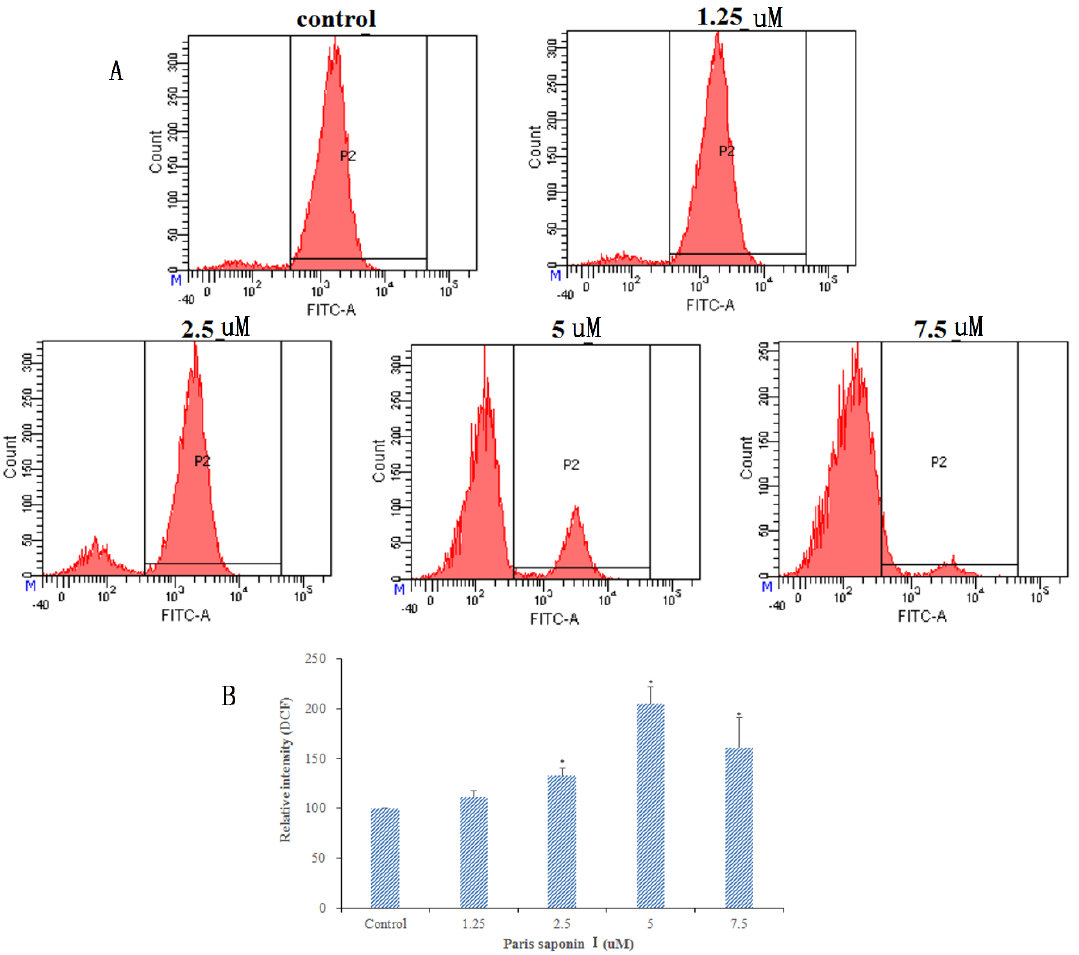
Figure 6. Effect of PSI on reactive oxygen species (ROS) generation in HepaRG cells after 24 h incubation. ( A ) Analysis of ROS generation using the oxidant sensitive fluorescent probe DCFH-DA. ( B ) The percentages of intracellular ROS after 24 h incubation with graded concentrations of PSI. Data are presented as mean ± SD. * p < 0.05, compared with the vehicle-treated group.